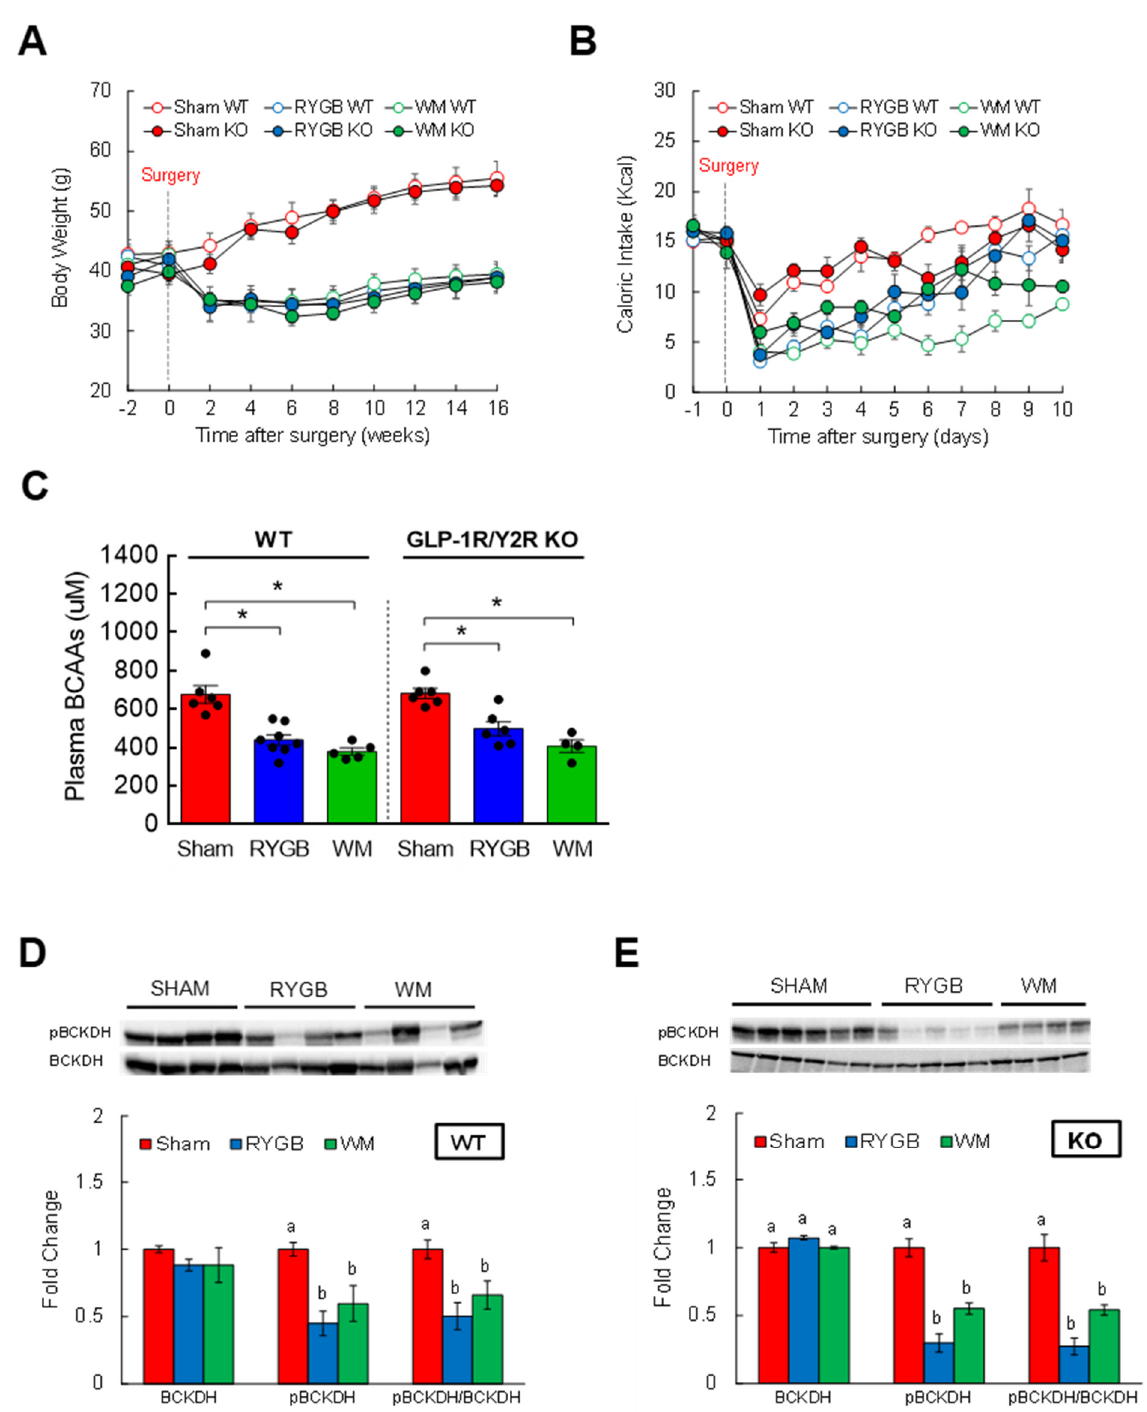
Figure 3. The ability of RYGB to lower plasma BCAAs is intact in mice lacking both GLP-1 and PYY signaling. Six-week-old male WT ( n = 5–8/group) or GLP-1R/Y2R double KO mice ( n = 4–6/group) were rendered obese on a 60% high-fat diet for 8 weeks prior to sham or RYGB surgery or caloric restriction. ( A ) Body weight before and after treatments for a 16-week period. ( B ) Daily caloric intake before and after treatments for 10 days. Analyzed by a two-way repeated measures ANOVA followed by a Bonferroni post hoc test. ( C ) Fasting plasma BCAAs measured at 16 weeks postoperatively. ( D ) Protein expression of BCKDH, its phosphorylated state, and inactivity index in WT or ( E ) in GLP-1R/Y2R KO mice. WT: n = 5–6/group; KO: n = 4–6/group. Analyzed by a one-way ANOVA followed by Tukey’s post hoc test. Bars with different letters are significantly different from each other; * p < 0.05.